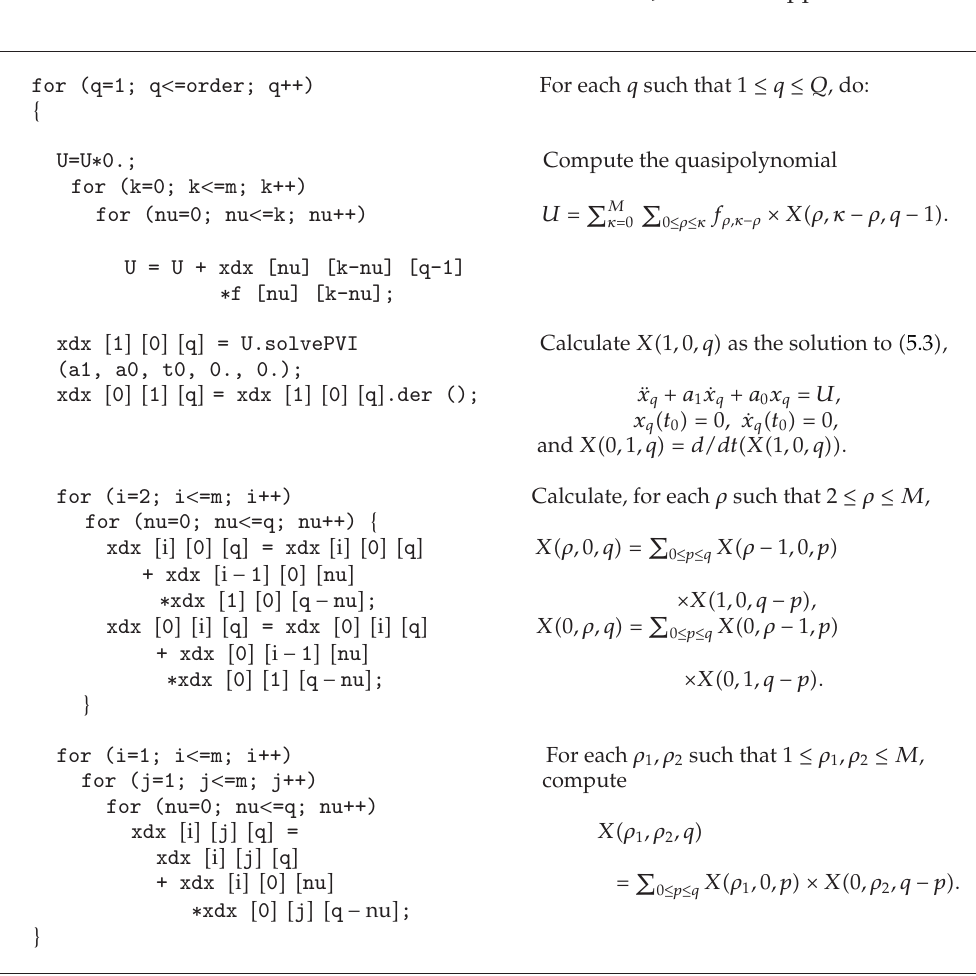
Algorithm 6: Implementation of the algorithm. Step (cid:3) 4 (cid:4)